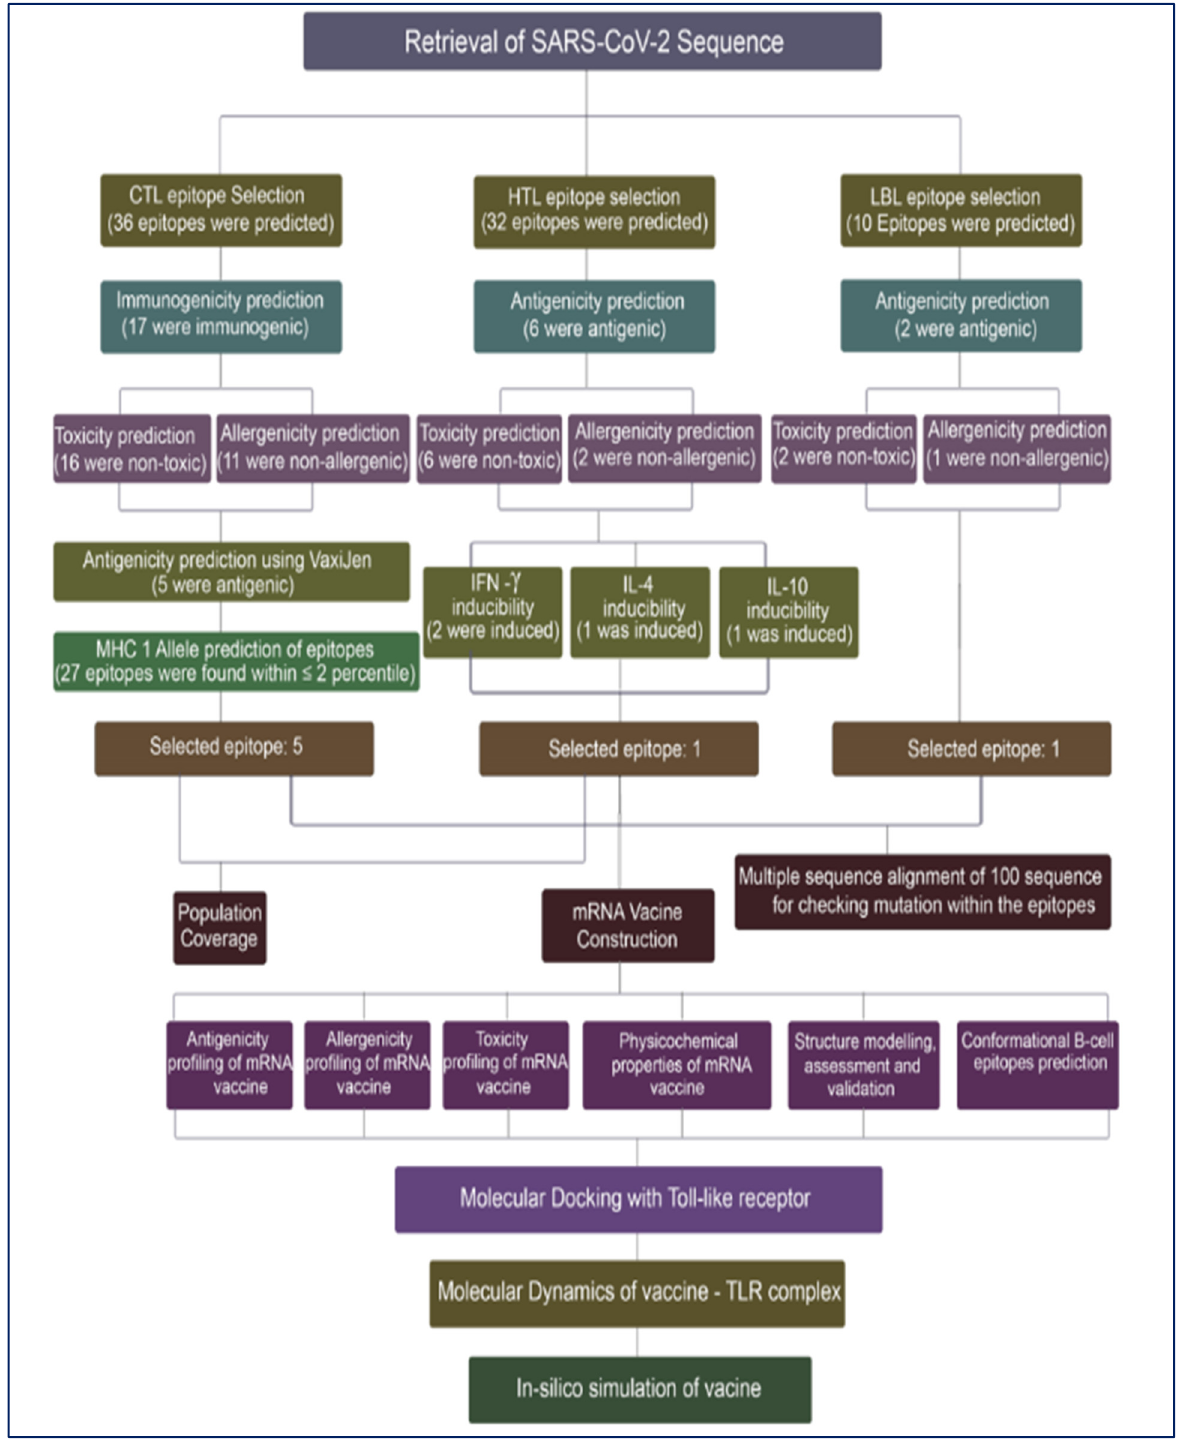
Figure 1. Systematic workflow diagram of the vaccine design for mRNA vaccine.